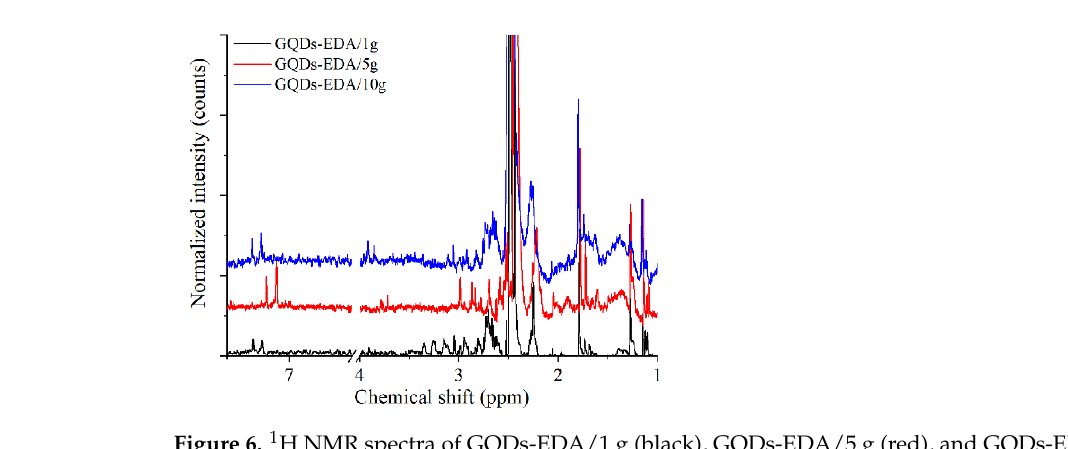
Figure 6. 1 H NMR spectra of GQDs-EDA/1 g (black), GQDs-EDA/5 g (red), and GQDs-EDA/10 g (blue).